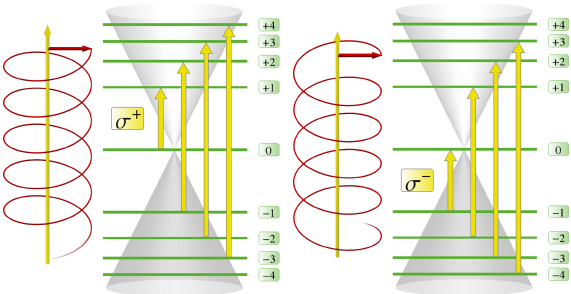
Figure 4: Optical transitions. The allowed optical interband transi- tions within the energetically lowest Landau levels are